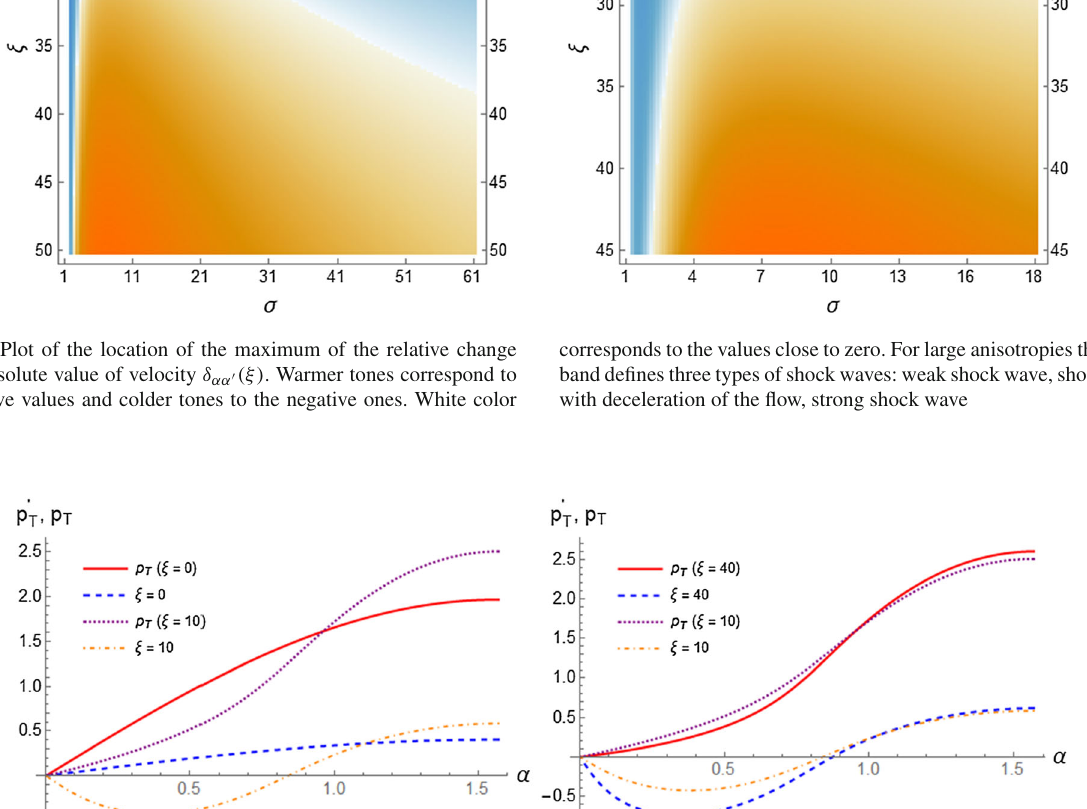
dependence of the transverse momentum p T (α | ξ) for ξ = 40 (solid), ξ = 10 (dotted) and p (cid:2) (α | ξ) for (α | ξ) for ξ = 40 (dashed), ξ = 10 (dashed- T T